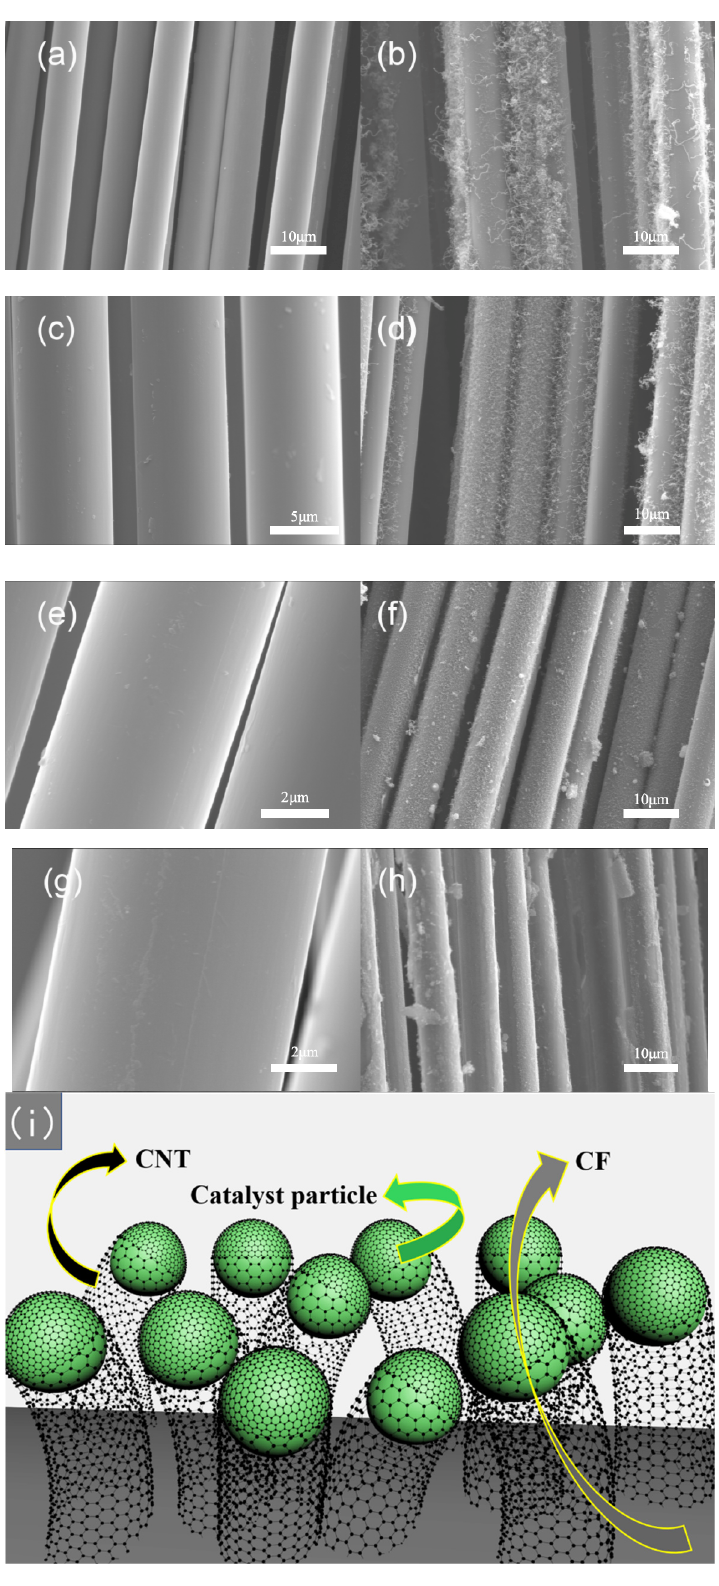
Figure 2. Surface morphology of ( a , b ) desized CFs and CFs pretreated with ( c , d ) HNO 3 , ( e , f ) EAO, ( g , h ) H 2 O 2 surface modification and CNTs grown on modified CFs, and ( i ) Structure diagram of CNTs/CF multi-scale reinforcements.